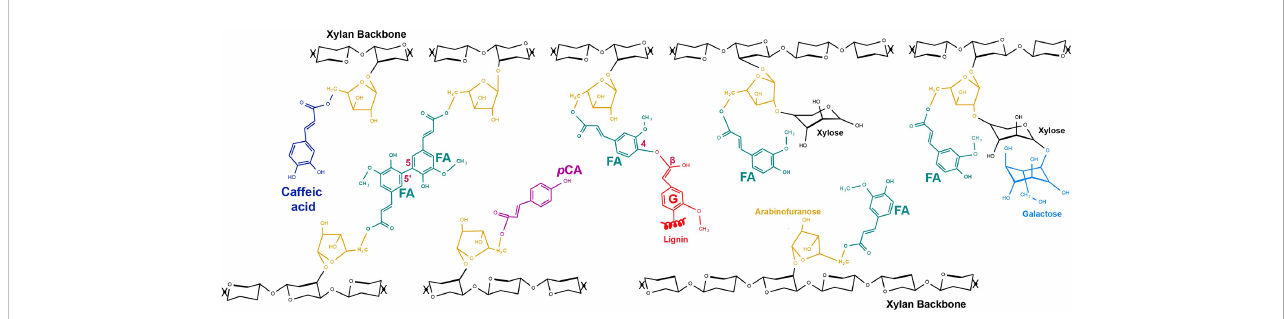
FIGURE 2 Hydroxycinnamoyl (HCA) decorations of grass glucuronoarabinoxylan (GAX). All HCA decorations occur on 5-O of Ara f which is a -(1,3)-linked to xylan backbone. FA decorations of GAX (turquoise) are abundant and include forms where Ara f is additionally substituted with b (1,2)-linked Xyl and this may itself be further substituted by b (1,4)-linked galactose. A FA 5,5 ’ dimer crosslinking GAX chains is shown as one example of a dimer that can crosslink GAX chains (see Figure 1). FA crosslinked to S lignin monomer is shown as one example of FA crosslinking GAX to lignin; FA can also link to G lignin monomers and to tricin (structures in Figure 3). p CA decorations (pink) of GAX can also be abundant in some tissues and smaller amounts of caffeoyl- decorations (dark blue) have recently been detected (Feijao et al., 2022). Glucuronic acid, O-methyl-glucuronic acid, acetyl substitutions, non-acylated Ara f that are commonly present on GAX are not shown